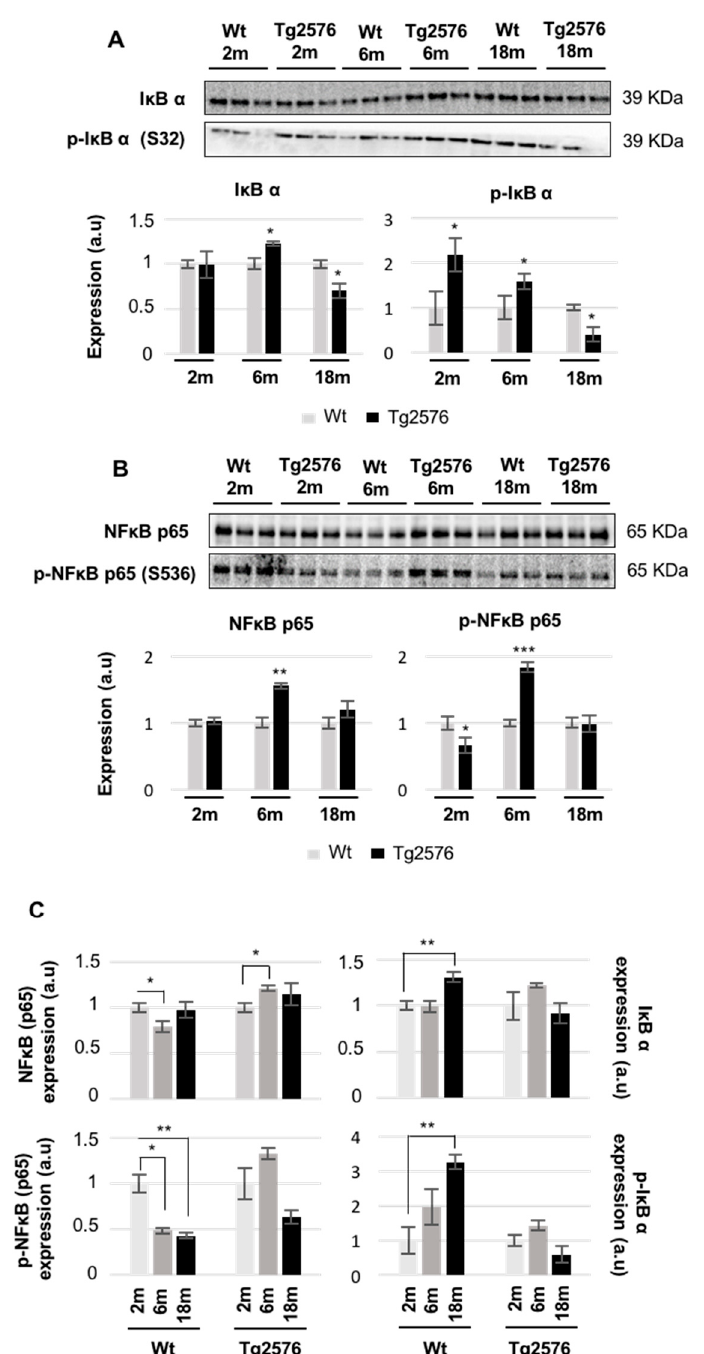
Figure 7. Time-dependent functionality of the OB I κ B α -NF κ B p65 complex in Tg2576 mice. Levels and residue-specific phosphorylation of the I κ B α ( A ); levels and residue-specific phosphorylation of NF κ B p65 subunit ( B ); Equal loading of the gels was assessed by stain-free digitalization. Panels show histograms of band densities. Data are presented as mean ± SEM from three independent OB samples per group. * p < 0.05 vs. control group; ** p < 0.01 vs. control group; *** p < 0.001 vs. control group. The expression of the I κ B α -NF κ B p65 complex was also evaluated during the aging process in WT and Tg2576 mice. * p < 0.05 vs. 2-month-old mice; ** p < 0.01 vs. 2-month-old mice ( C ). Equal loading control and quantitation values have been included in Table S5. m: month; a.u.: arbitrary units